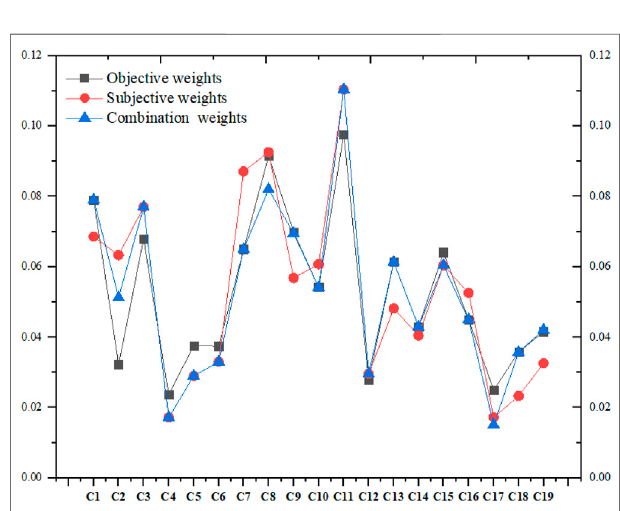
FIGURE 3 | Evolution of weight of each indicator by three